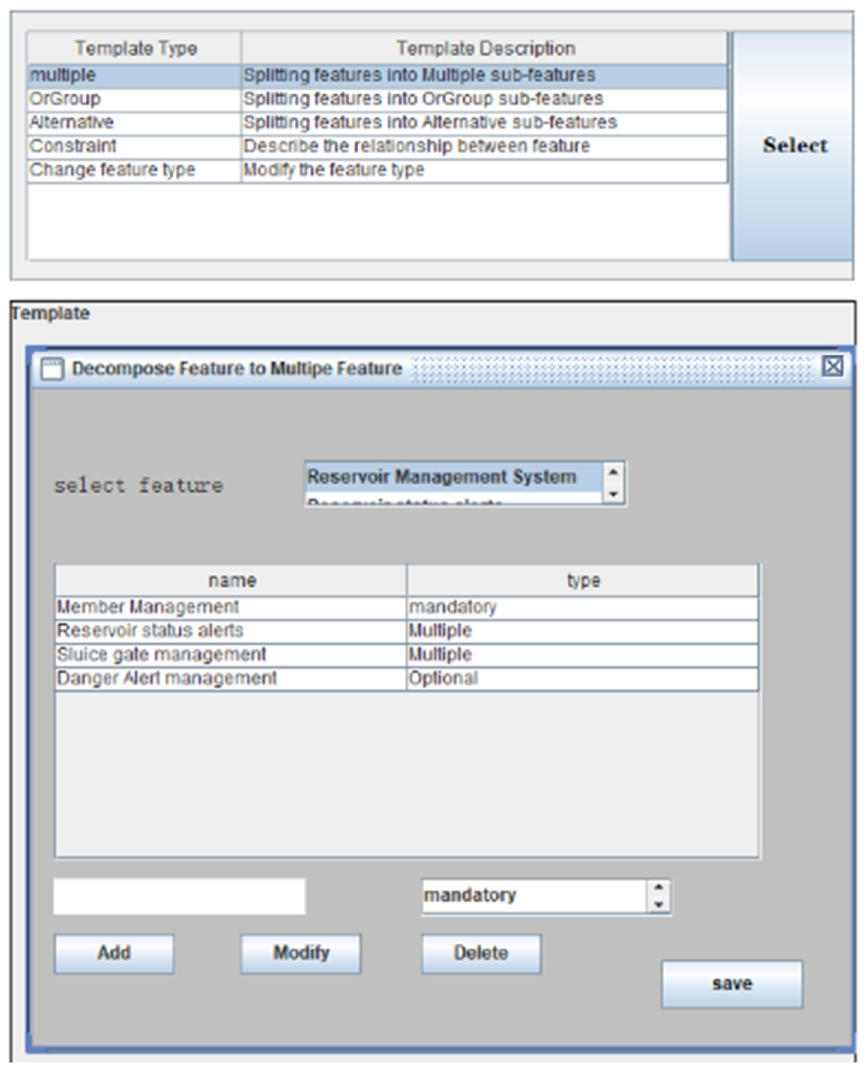
Figure 3. Screenshot of the tool.